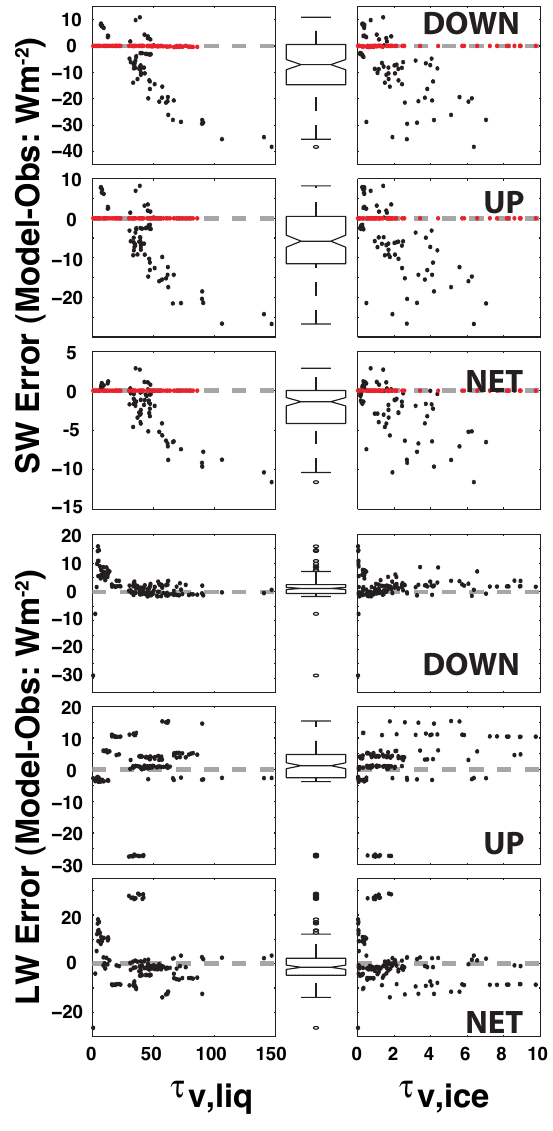
Fig. 4. Errors in modeled surface shortwave (SW, top three rows) and longwave (LW, bottom three rows) compared with liquid ( τ v,liq , left) and ice ( τ v,ice , right) visible optical thickness. Boxplots in between the liquid and ice comparisons provide error statistics, demonstrating the mean (center notch), IQR (ends of boxes), 1.5xIQR beyond 25th and 75th percentiles (ends of whiskers) and outliers (circles). For shortwave analysis, nighttime cases (red) are not included in the boxplots.